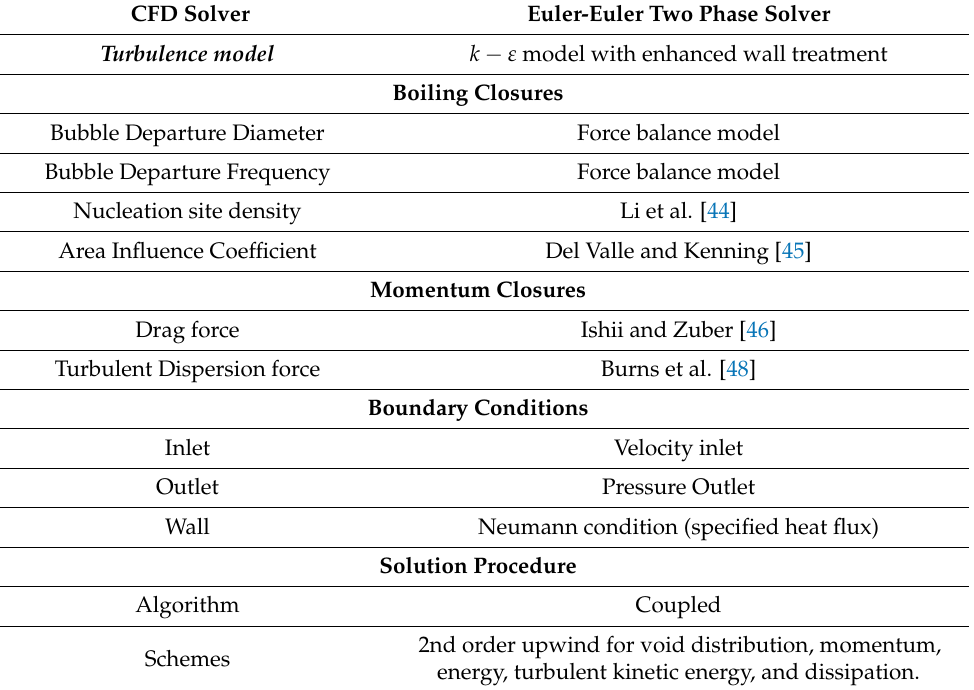
Table 4. Summary of CFD model.